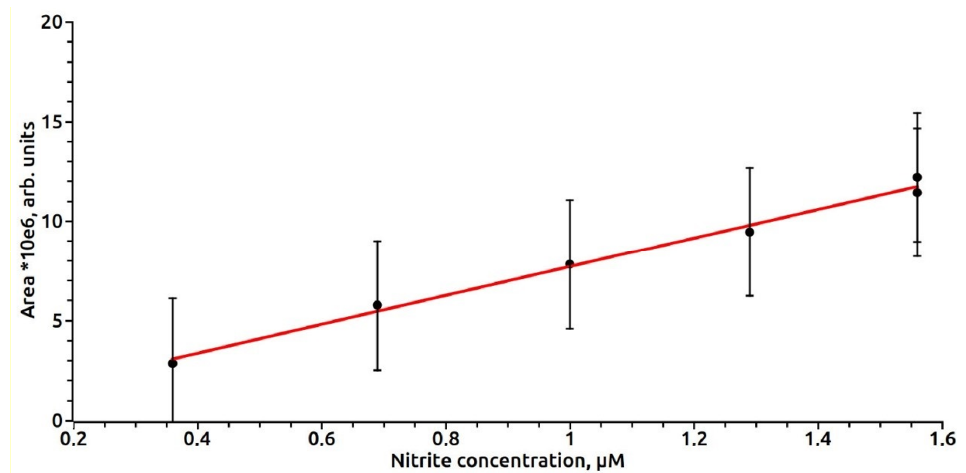
Figure 1. The dependence of the intensity of the EPR signal on the nitrite concentration in the sample after removal of serum proteins.